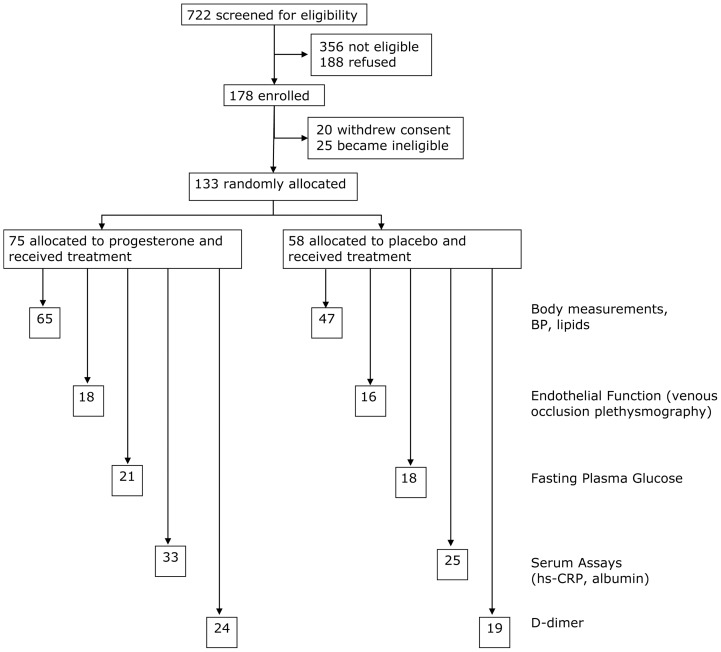
Flow Diagram Of Healthy Early Postmenopausal Participants Through The Cardiovascular Assessment Portion Of The Progesterone For Hot Flushes Randomized Controlled Trial.This shows those excluded before randomization for abnormal historical or physical examination results, those secondarily excluded because of laboratory abnormalities and those randomized to progesterone or placebo arms. Also indicated are those with analyzable venous occlusion plethysmography assessment of the endothelial function effects of progesterone or placebo, morphometric, blood pressure, lipid and inflammation data.